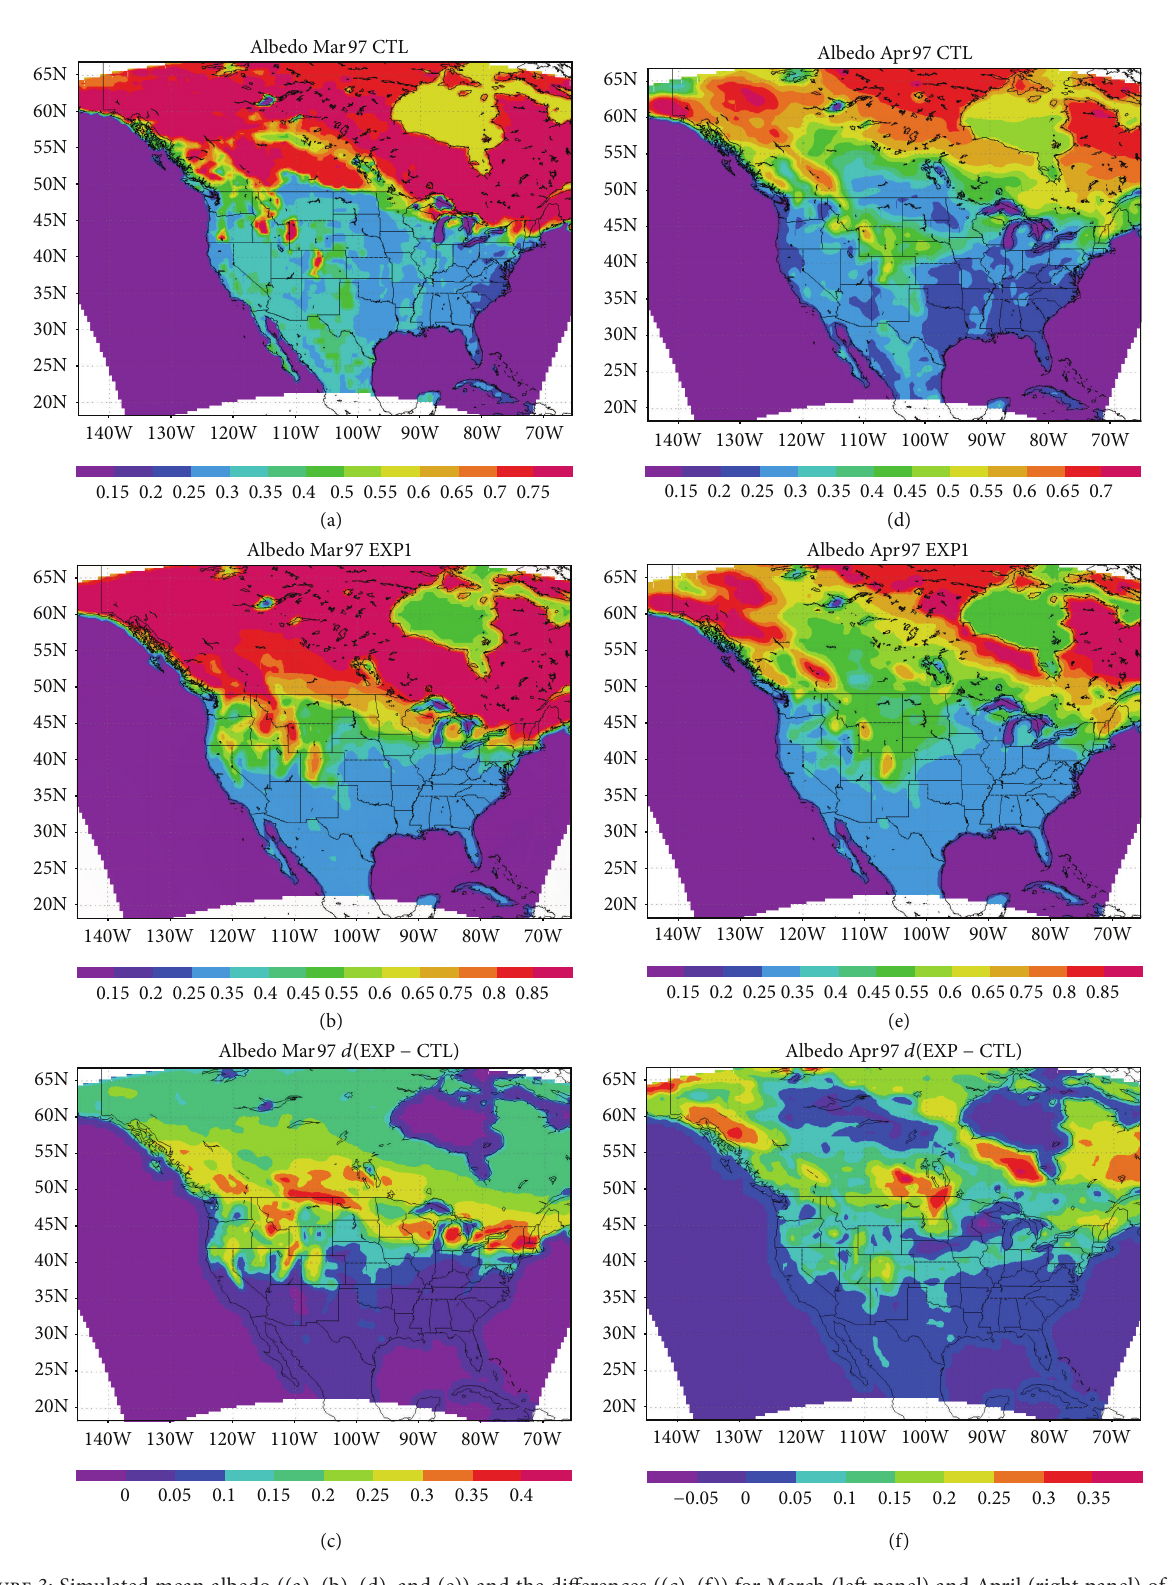
Figure 3: Simulated mean albedo ((a), (b), (d), and (e)) and the differences ((c), (f)) for March (left panel) and April (right panel) of 1997 from CTL and EXP1,